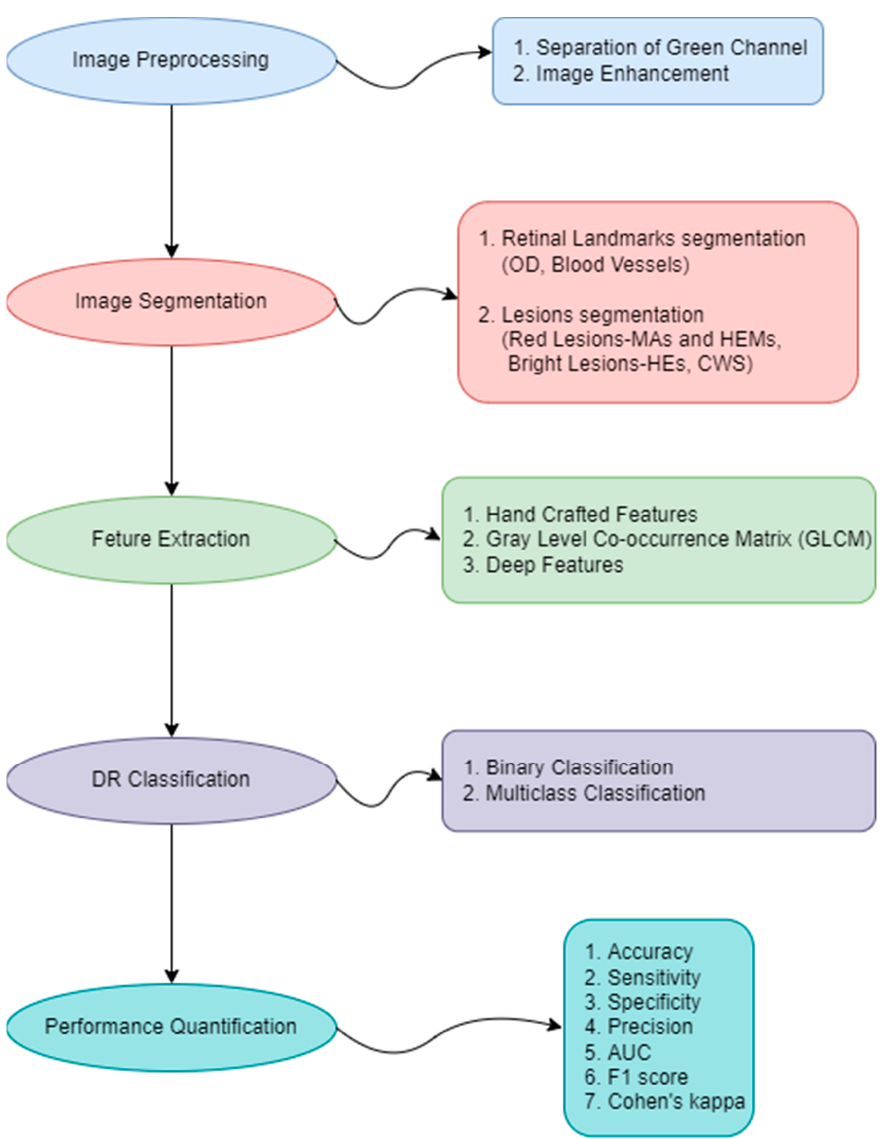
Figure 19. Steps in diabetic retinopathy detection.